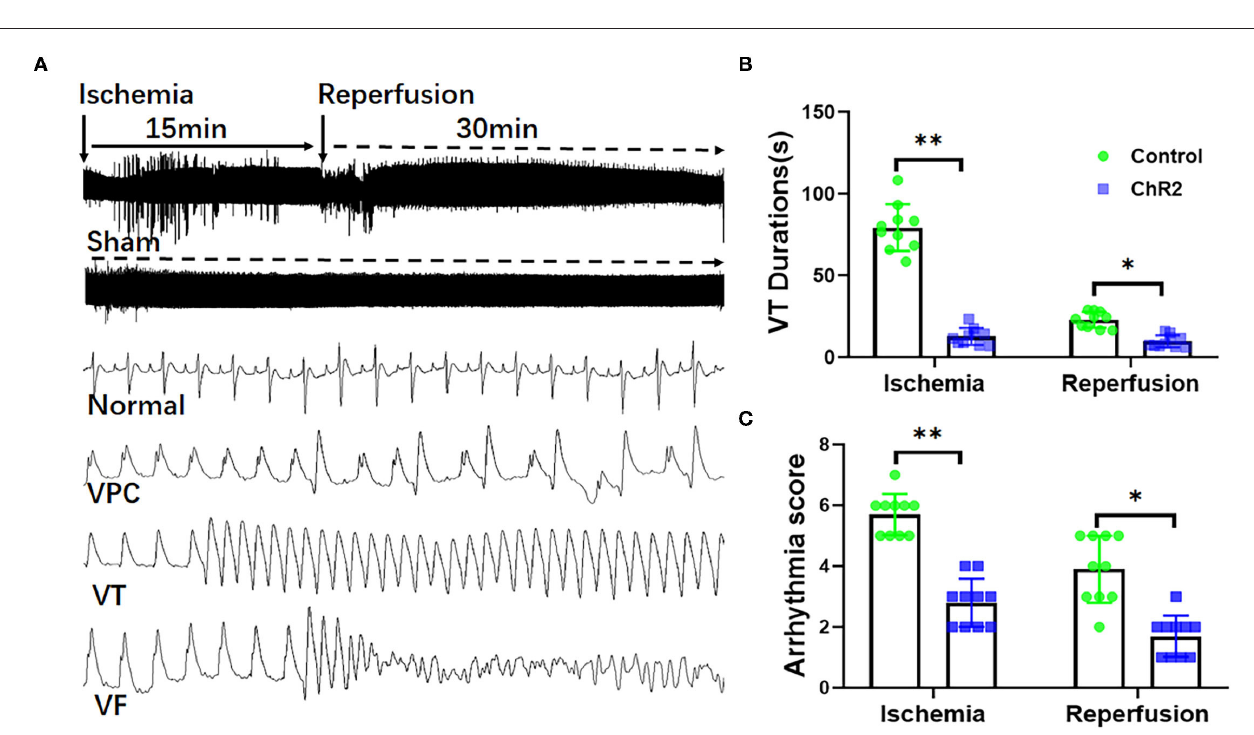
FIGURE 2 | Selective optical stimulation of the dorsal horn prevents arrhythmias during myocardial ischemia-reperfusion. Representative traces of ECG and arrhythmias including ventricular premature contraction (VPCs), ventricular tachycardias (VTs), and ventricular fibrillation (VF) during 15min of ischemia and 30min of reperfusion (A) . Analysis of VT and VF showed that optical stimulation of the dorsal horn significantly inhibited VT duration (B) and arrhythmia score (C) . Data are expressed as mean ± SD. A paired t -test was used to compare parameters before and after light stimulation and a t -test was used to compare differences between the ChR2 and control groups ( n = 10 for each group; * P < 0.05, ** P <